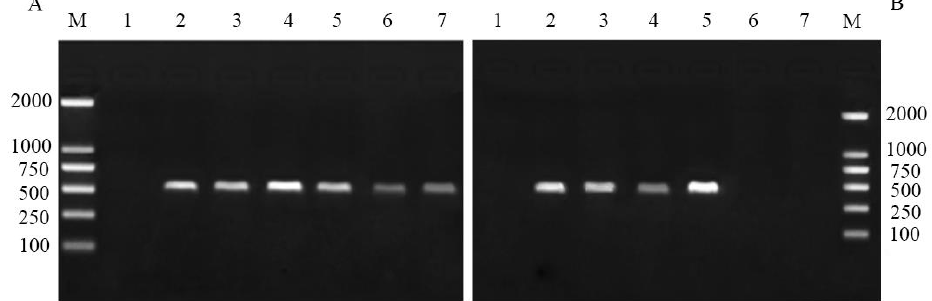
Figure 1. ( A ) PCR detection of Buchnera aphidicola in pea aphids on day 6 after antibiotic treatment. ( B ) PCR detection of Buchnera in pea aphids on day 11 after antibiotic treatment. M: molecular weight marker, line 1: negative control of ddH 2 O, line 2: antibiotics of chloraomycetin, 3: penicillin-GK salt, 4: streptomycin sulfate, 5: chlortetracycline HCl, 6: rifampicin, 7: oxytetracycline HCl.